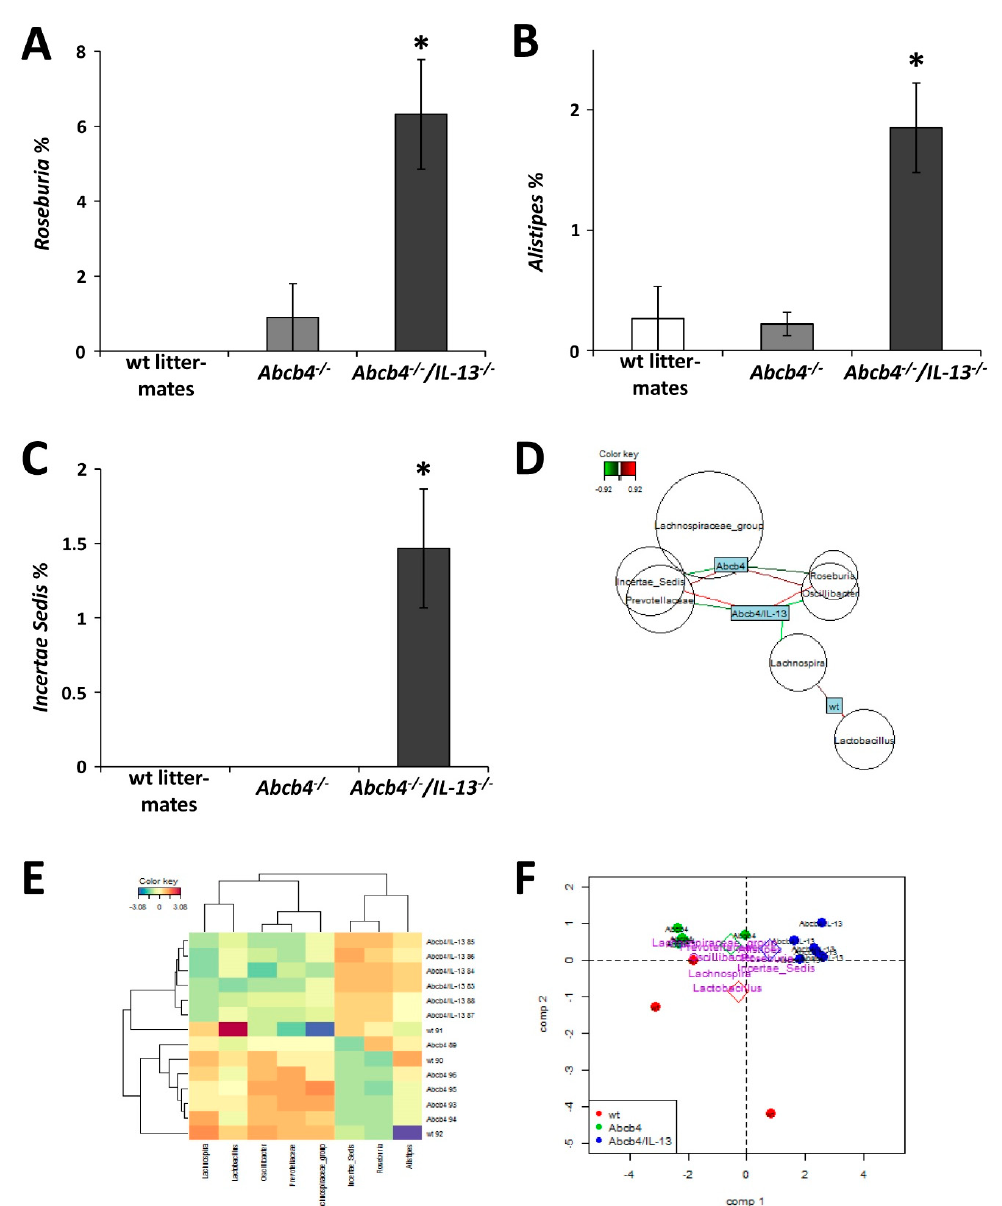
Figure 6. IL-13 knockout reversed specific intestinal microbiome associations in cholestatic mice. ( A – C ) Intestinal occurrence of Roseburia , Alistipes , and Incertae Sedis was increased in Abcb4 − / − /IL-13 − / − mice. Mean ± SEM is depicted, * p < 0.05 was considered significant. ( D ) Network displays the negative association between Abcb4 − / − mice and Roseburia , and Incertae Sedis (green edges) and the positive association (red edges) with Prevotella , and Oscillibacter . In Abcb4 − / − /IL-13 − / − mice, these associations are in reverse. In addition, Abcb4 − / − /IL-13 − / − mice are negatively associated with Lachnospira . ( E ) Heatmap and hierarchical clustering of different mice indicates a high similarity between Abcb4 − / − and wildtype mice, due to the decreased occurrence of Roseburia , Alistipes , and Incertae Sedis in Abcb4 − / − mice and the increased occurrence of Prevotella , the group of Lachnospiraceae , and Oscillibacter . ( F ) The biplot clearly shows a distinction between Abcb4 − / − /IL-13 − / − mice and Abcb4 − / − mice.